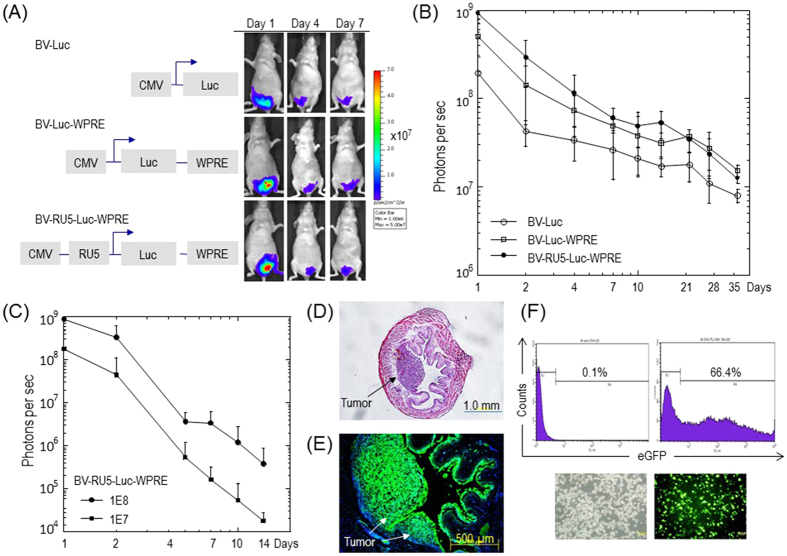
In vivo baculoviral transduction after intravesical instillation of baculoviral vectors in mice.(A) Bioluminescence images of luciferase reporter gene expression in immunodeficient BALB/c nude mice. Images of representative animals transduced with 3 different baculoviral vectors (107 viral particles per mouse) are shown. Heat map represents the transgene expression area and color represents the intensity. The schematic structures of baculoviral vector expression cassettes are shown on the left. Abbreviations: CMV: the human cytomegalovirus immediate-early gene promoter and enhancer; WPRE: the woodchuck hepatitis virus post-transcriptional regulatory element; RU5: R segment and part of the U5 sequence of the long terminal repeat from the human T-cell leukemia virus type 1. (B) Time course analysis of luciferase reporter gene expression in BALB/c nude mice. In vivo gene expression levels are quantified by measuring bioluminescence signals. The data represent the mean + s.d., n = 5 per group. (C) Time course analysis of luciferase reporter gene expression in C57BL/6 mice. Mice were transduced with the baculoviral vector BV-RU5-Luc-WPRE at a dose of 108 or 107 viral particles per mouse. The data represent the mean + s.d., n = 5 per group. (D) MB49 tumor growth in the bladder of C57BL/6 mice. MB49 mouse bladder tumor cells (105 per mouse) were implanted into poly-L-lysine pre-treated bladder and allowed to establish tumors for one week. A bright field image of an H&E stained section showing mouse bladder architecture and a tumor inside the bladder (arrow). (E) Immunostaining to demonstrate baculoviral transduction in bladder tumors. Tumor-bearing bladders were collected 24 hours after transduction with BV-RU5-Luc-WPRE for immunostaining with antibodies against the luciferase protein. A fluorescence image is shown. (F) Flow cytometric analysis to demonstrate transduction of MB49 tumor cells with BV-RU5-eGFP-WPRE. Phase contrast and fluorescence images of transduced cells are shown in the bottom panels.